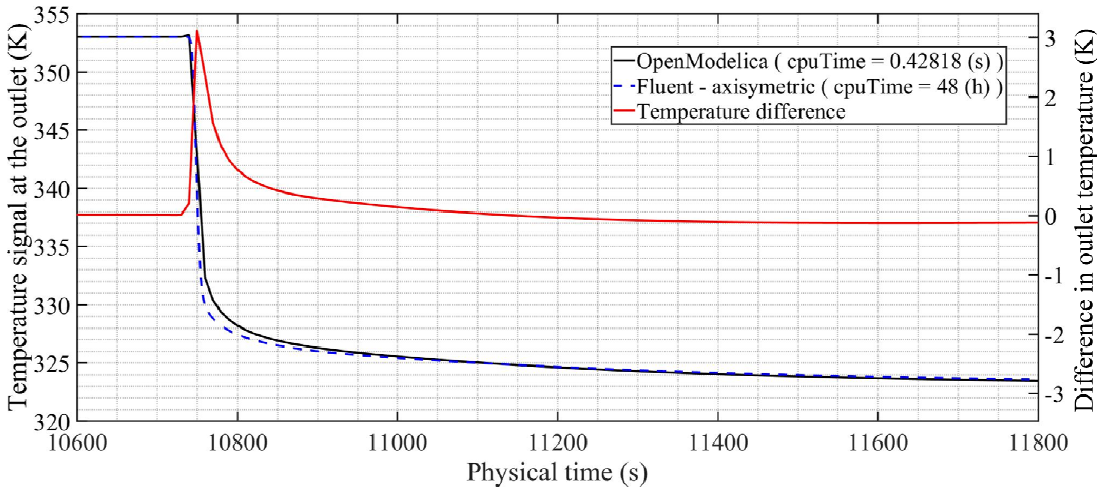
Figure 23. Comparison with a model from Fluent (the solid material property differ slightly here—mass density is 7850 kg/m 3 , heat conductivity is 50 W/(mK), and specific heat capacity is 500 J/(kgK)).